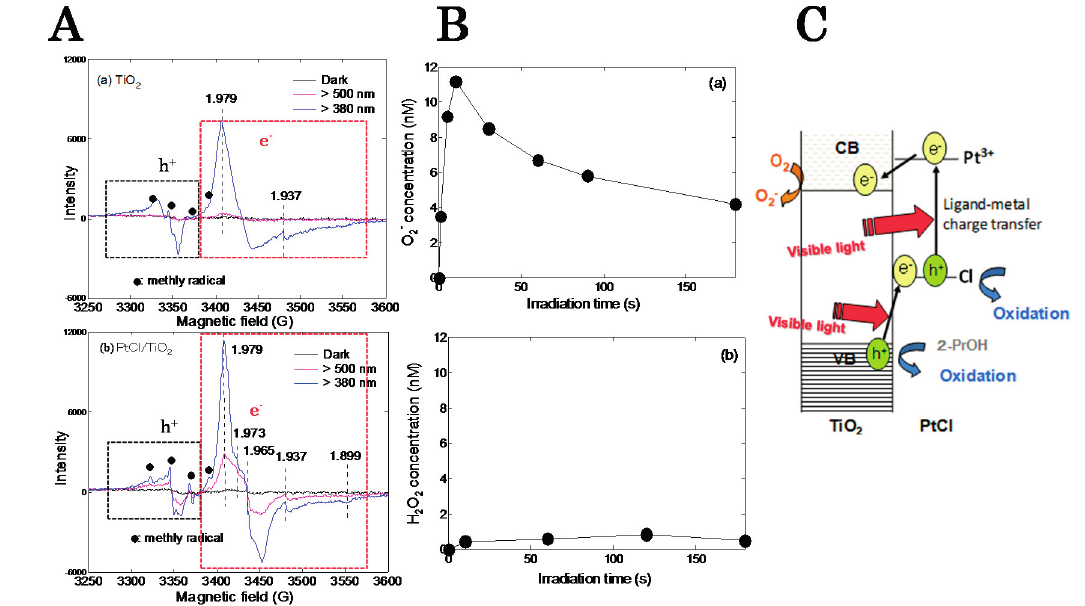
Figure 7. ( A ) ESR spectra of electrons and holes for ( a ) TiO 2 and ( b ) PtCl/TiO 2 ; ( B ) ( a ) •O 2 − and ( b ) H 2 O 2 generated on the PtCl/TiO 2 under visible light irradiation. ( C ) Photocatalytic reaction mechanism of PtCl/TiO 2 . Reprinted with permission from [30]. © 2012 American Chemical